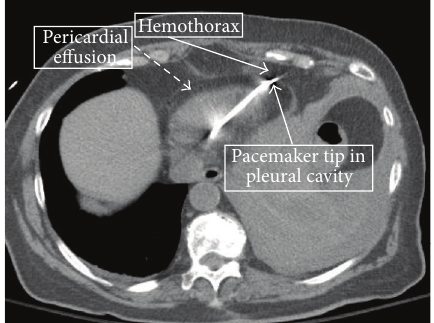
Figure 1: Chest X-ray AP view: opacity at left base consistent with a moderate left-sided pleural effusion; pacemaker leads appear to be present in the right ventricle.